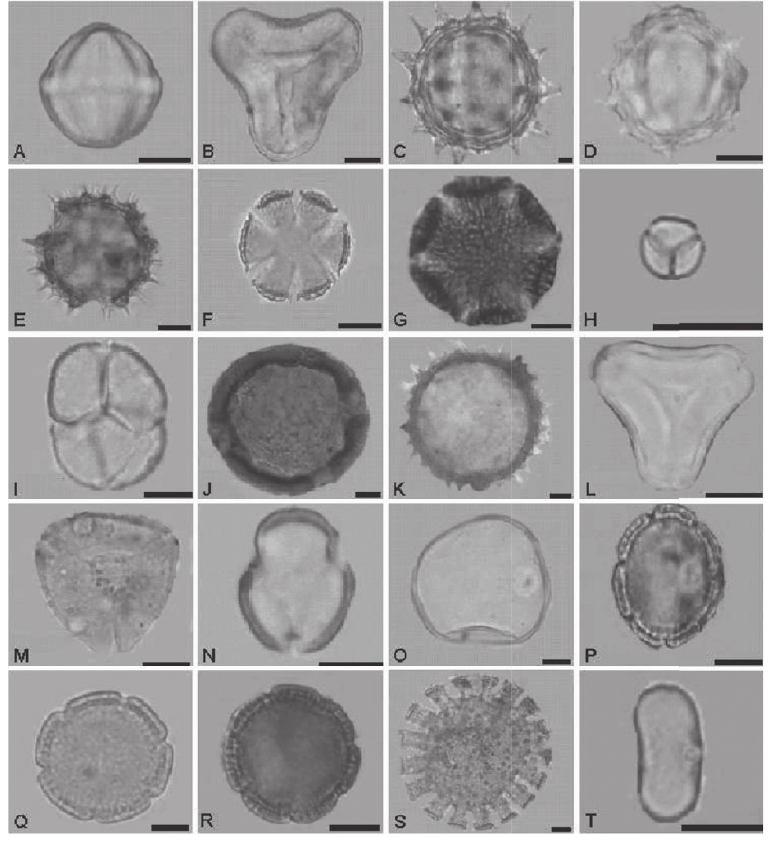
Figure 3 - Pollen types found in the propolis samples investigated from the territory of the Agreste of Alagoinhas. A. Anarcadiaceae, Schinus. B. Arecaceae, Syagrus . C-E. Asteraceae: C. Eupatorium I. D. Mikania , E. Venonia I. F-G. Lamiaceae: F. Hyptis , G. Salvia H-I. Fabaceae: H. Mimosa pudica , I. Mimosa tenuifl ora J. Malpighiaceae, Banisteriopsis K . Malvaceae, Sida